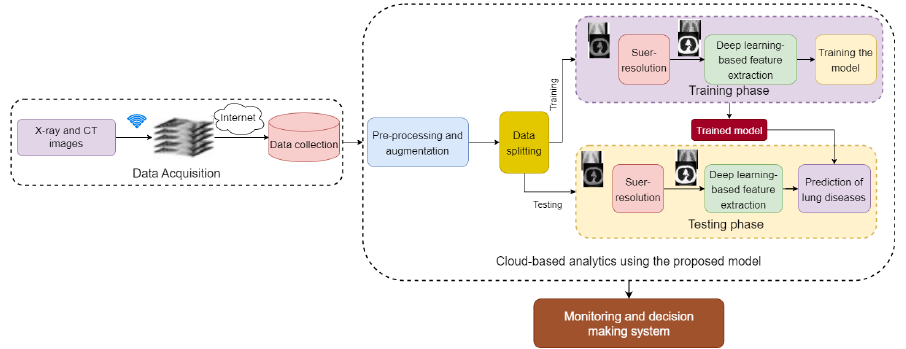
Figure 1. Main architecture of the proposed framework.